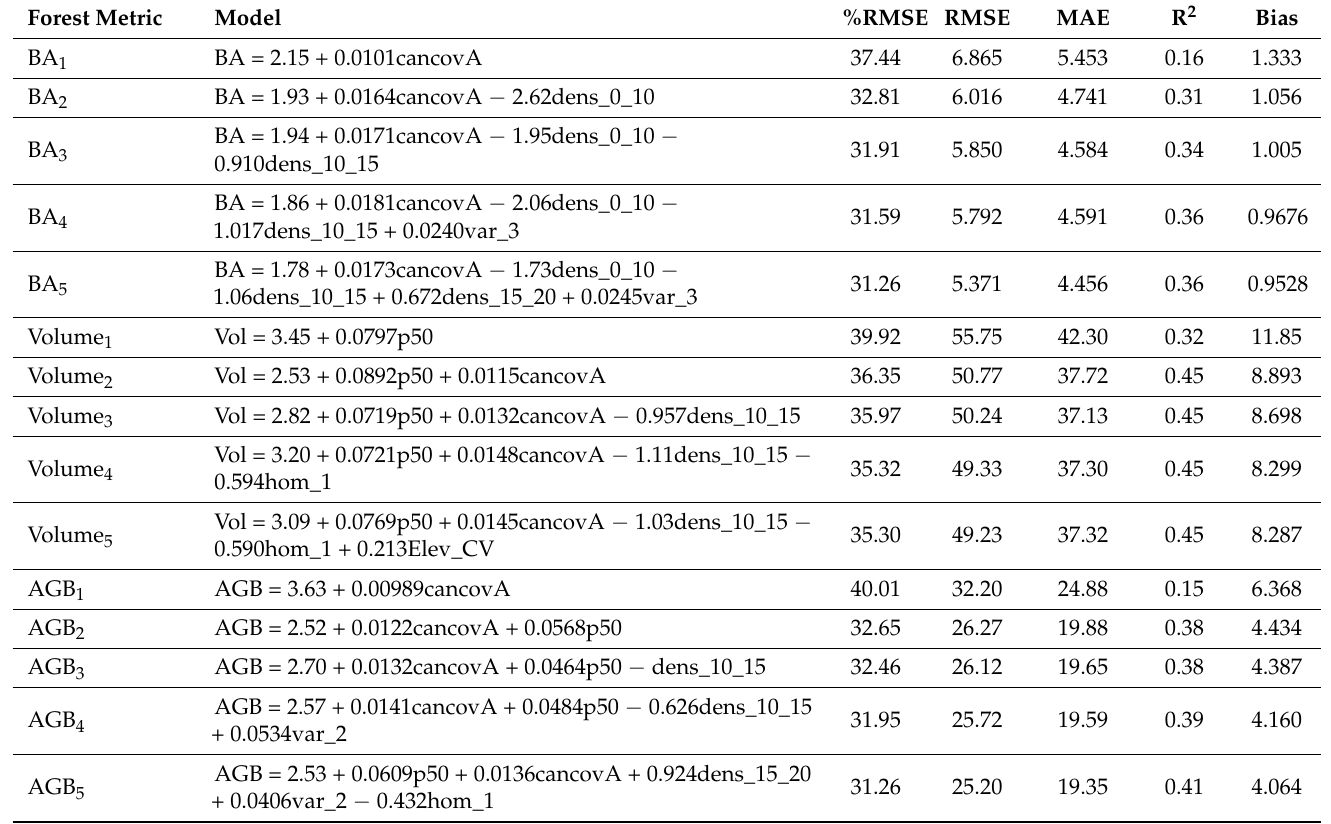
Table A1. The best models produced for models of one to five variables for BA, volume, and AGB. Forest Metric